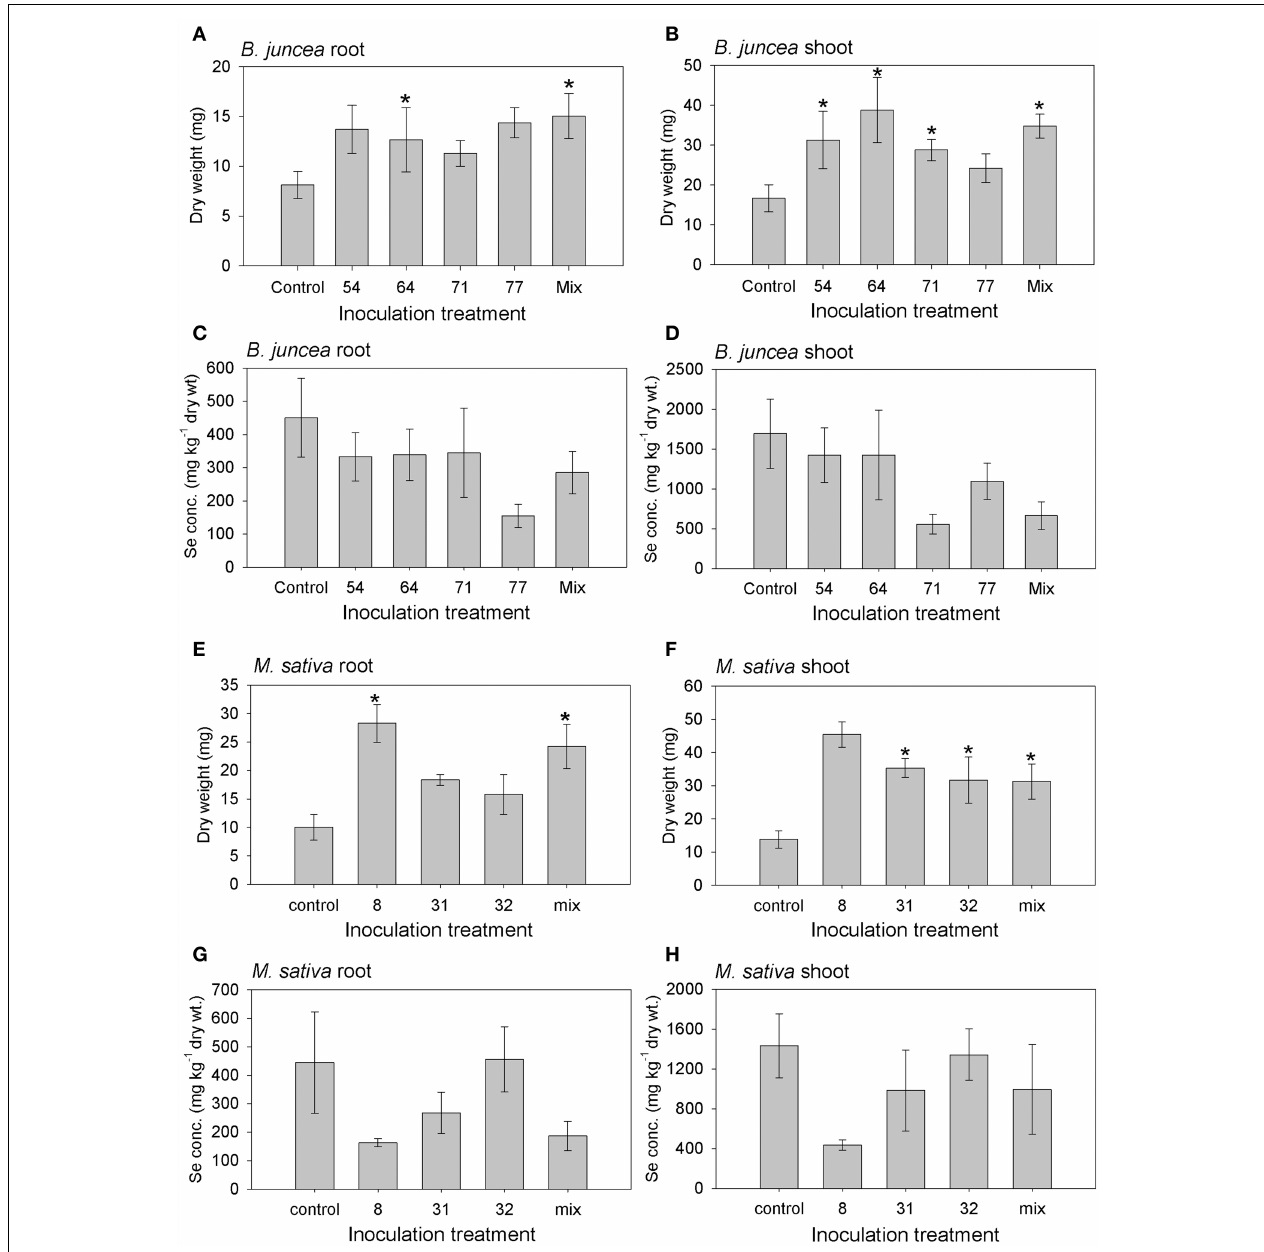
FIGURE 6 | Results from inoculation of M. sativa and B. juncea with endophytic bacteria isolated from Se hyperaccumulators A. bisulcatus (#8, 31, 32) and S. pinnata (#54, 64, 71, 77), respectively. Additional treatments consisted of a mix of all 3 or 4 isolates, and an uninoculated control. (A) B. juncea root dry weight; (B) B. juncea shoot dry weight; (C) B. juncea root Se concentration; (D)